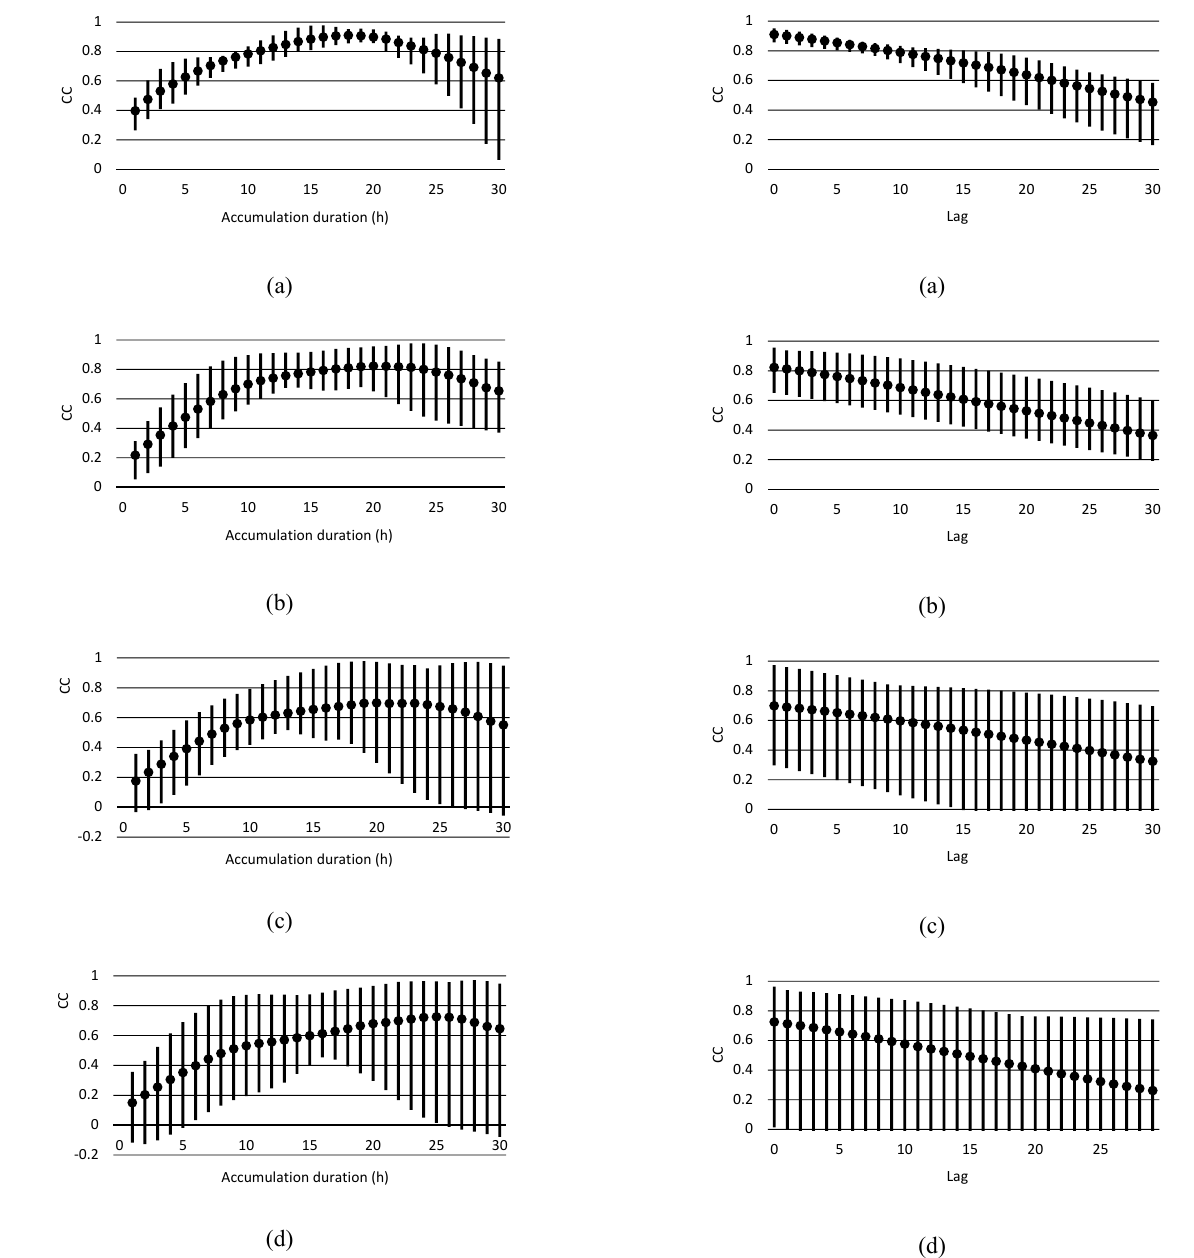
match the observation data.